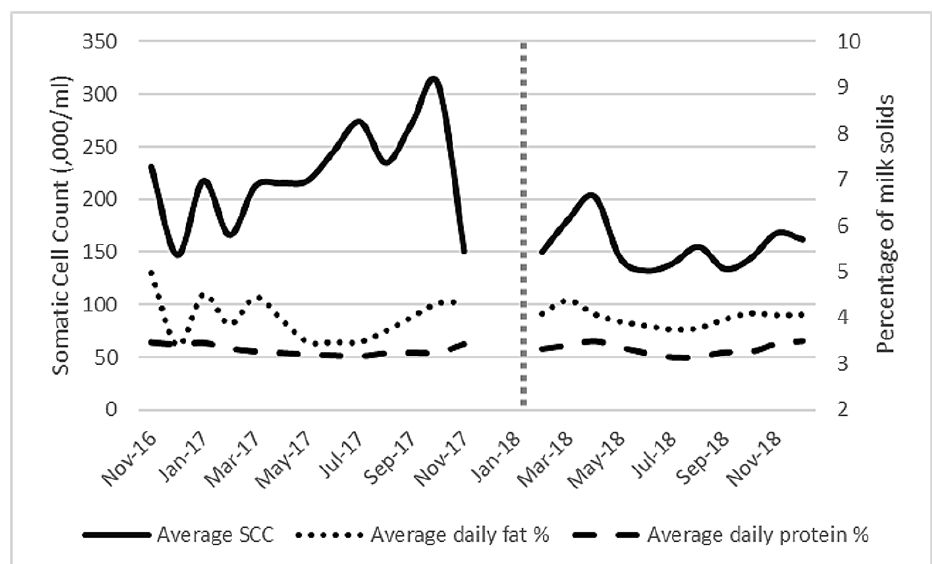
Figure 4. Average milk constituents (average daily fat and protein percentage) and average bulk milk somatic cell count (× 10 −3 /mL) for all lactating cows (101 ± 6) on the study farm from November 2016 to December 2018. Vertical dotted line represents AMS installation.